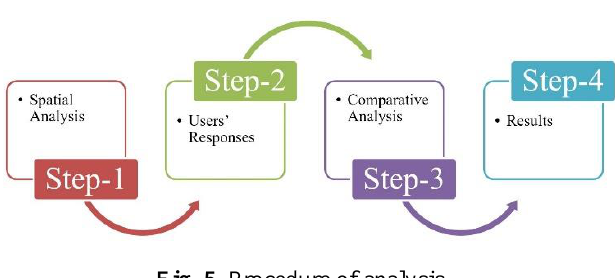
Fig. 5. Procedure of analysis